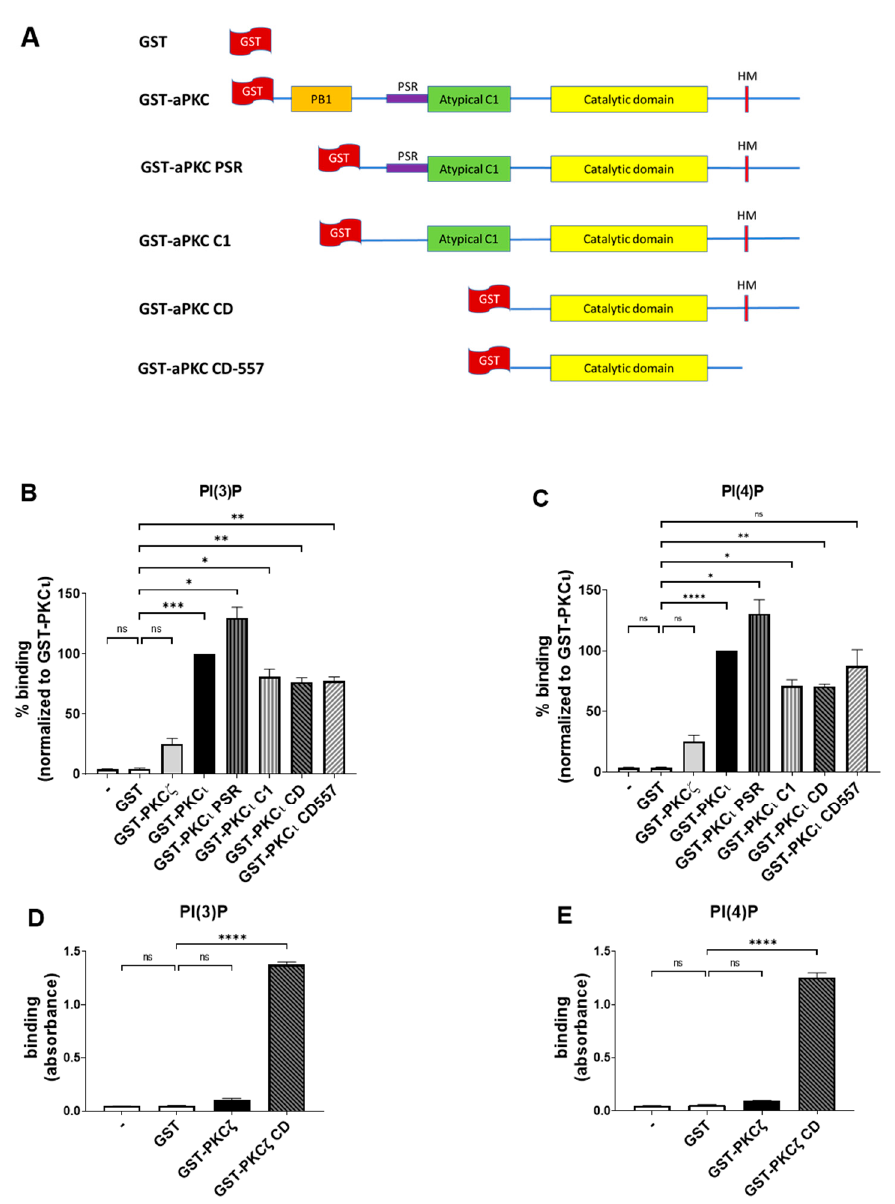
Figure 3. PKC ι , but not PKC ζ , binds selectively to both PI(3)P and PI(4)P. ( A ) Schematic domain structure of GST tagged PKC ζ , PKC ι , and the deletion mutants used in this study. ( B ) GST-PKC ζ , GST-PKC ι , and deletion mutants binding on Cova PIP screening plates coated with PI(3)P. Purified GST was used as a negative control. Data are the mean ± SEM of three independent experiments. ( C ) GST-PKC ζ , GST-PKC ι , and deletion mutants binding on Cova PIP screening plates coated with PI(4)P. Purified GST was used as a negative control. Data are the mean ± SEM of three independent experiments. ( D ) GST-PKC ζ and GST-PKC ζ CD binding on Cova PIP screening plates coated with PI(3)P. Purified GST was used as a negative control. Data are the mean ± SEM of three independent experiments. ( E ) GST-PKC ζ and GST-PKC ζ CD binding on Cova PIP screening plates coated with PI(4)P. Purified GST was used as a negative control. Data are the mean ± SEM of three independent experiments. A single, double, triple and four asterisks denote their significance of p -value ≤